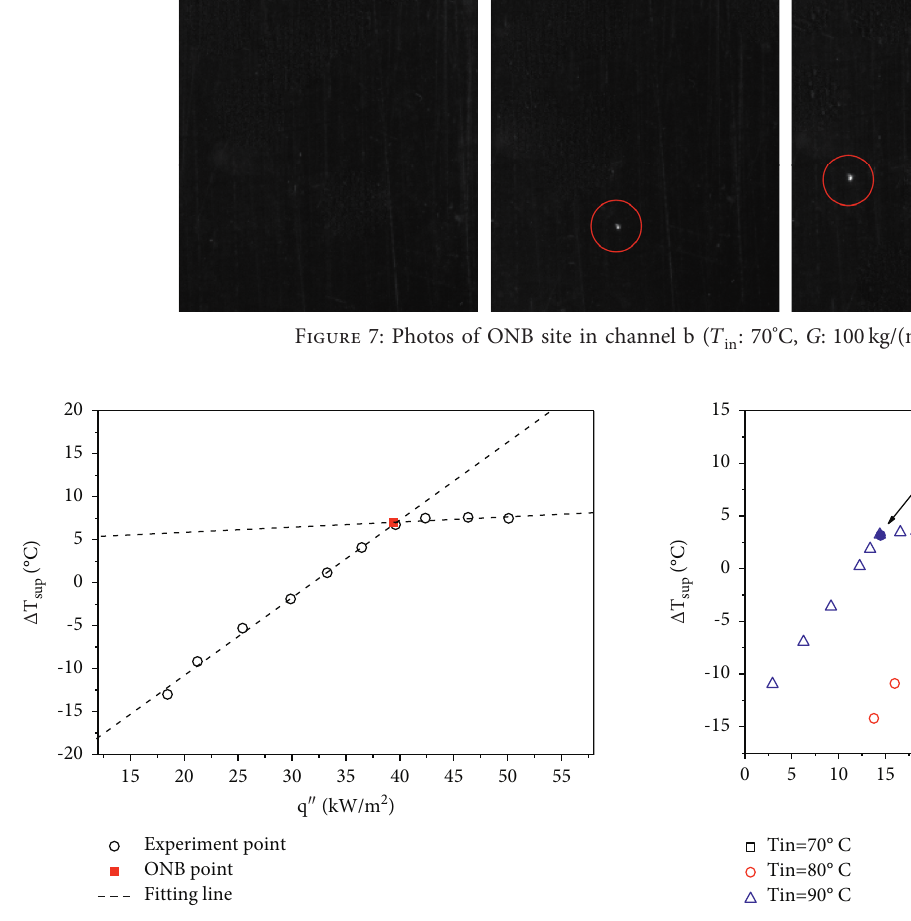
Figure 9: Wall superheat at ONB in the channel a ( G : 100kg/ : 70 ° C, G : in (m 2 ·